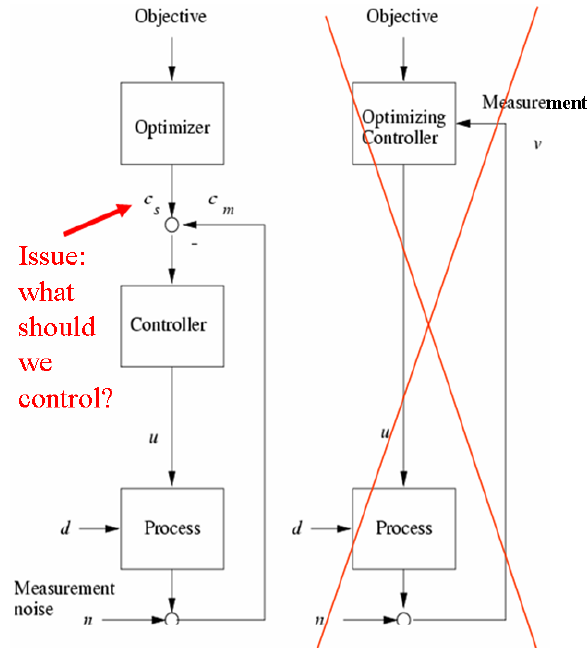
Figure 5: Implementation of optimal operation: We want to replace open-loop “feedforward” op- timization (right figure) by a self-optimizing feedback scheme (left figure) with constant setpoint c s (such that the role of the “opti- mizer” can be